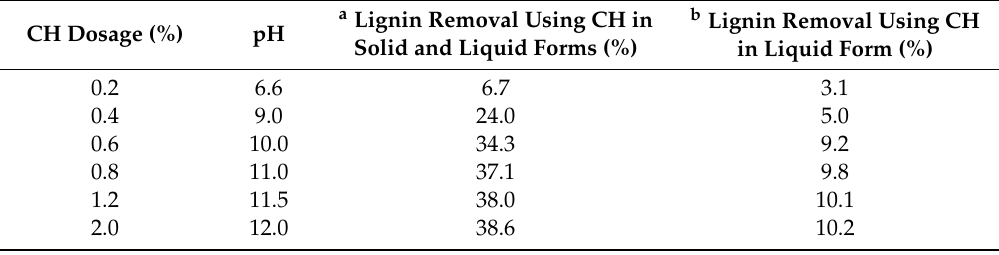
Table 2. E ff ect of CH existing forms and pH on lignin removal in CH treatment process. CH Dosage (%) pH